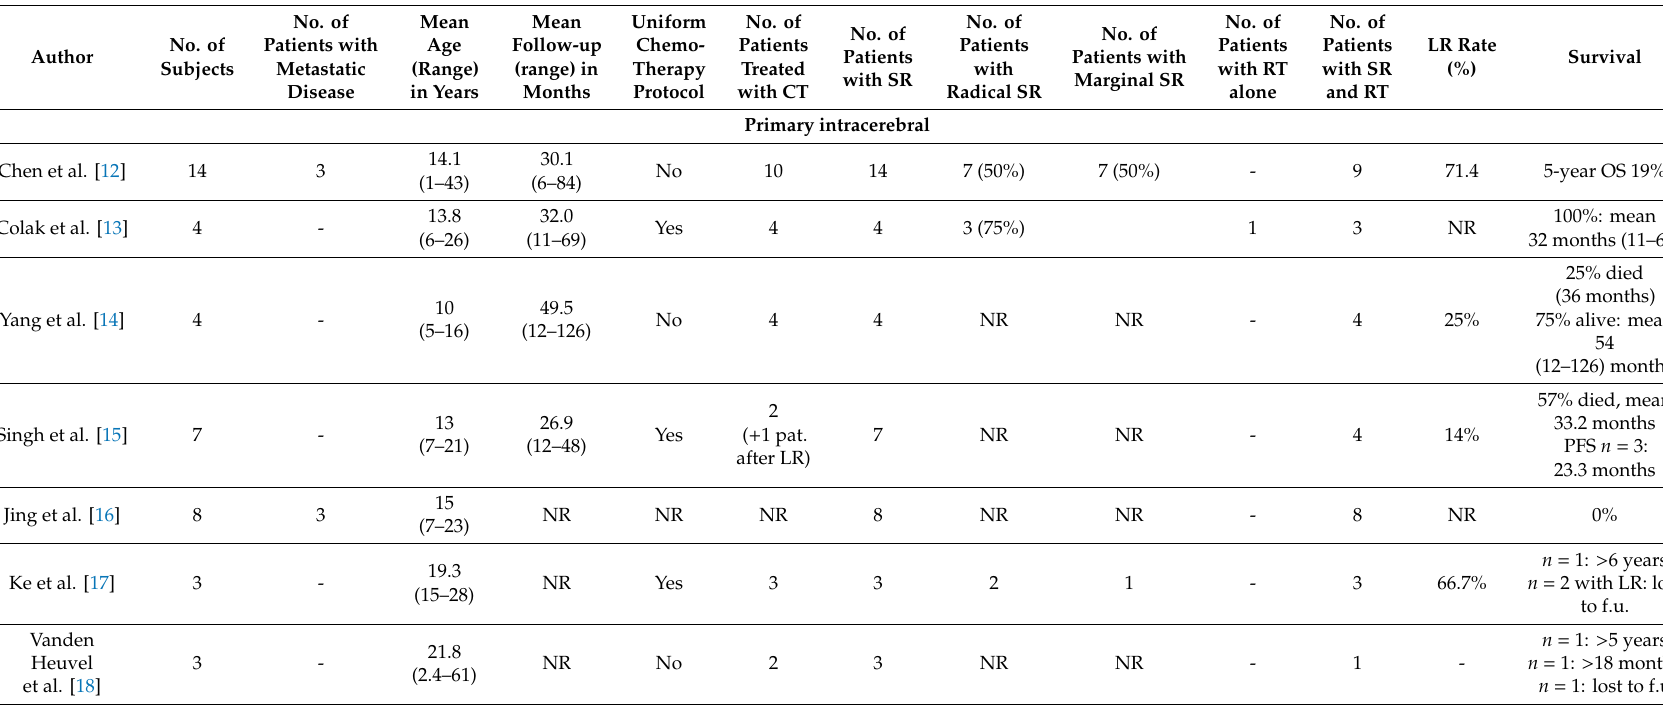
Table 3. Characteristics and treatment modalities of studies with case series of three or more patients with primary intracranial Ewing